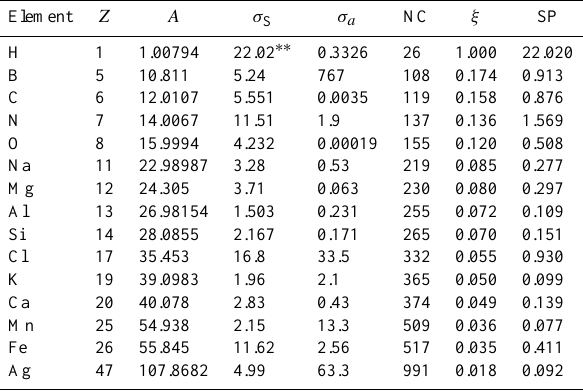
Table 1. Nuclear properties of major rock constituents: atomic number ( Z ), atomic weight ( A ) in grams, total scattering cross section ( σ S ) , absorption cross section ( σ a ) for 2200ms − 1 neu- trons (20 ◦ C), average number of collisions (NC) required to reduce a neutron’s energy from 2MeV to 0.025eV by elas- tic scattering, average logarithmic energy decrement per colli- sion ( ξ) , and neutron stopping power (SP). Cross sections units in barn (1 barn=10 − 24 cm 2 ) and values were extracted from Sears (1992). Calculations are based on equations presented in Ri- nard et al. (2009) and Krane (1988) ∗